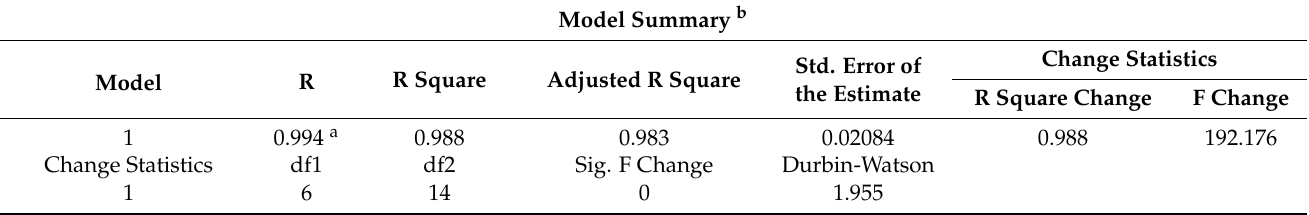
Table 1. The model of analysis for the EU.